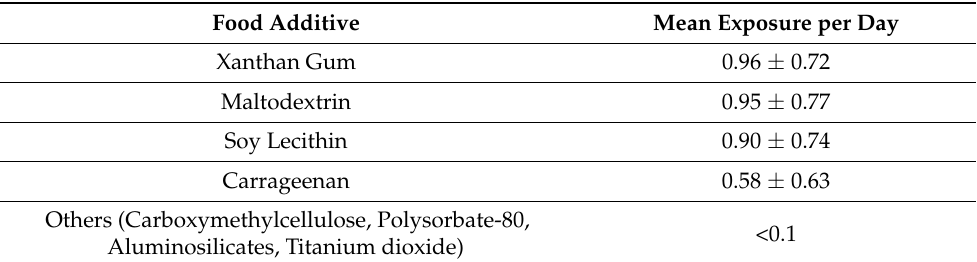
Table 1. Mean exposures per day of carrageenan and other food additives in a population of 138 children with Crohn’s disease—Adapted from Dale Lee et al., 2018 [2].